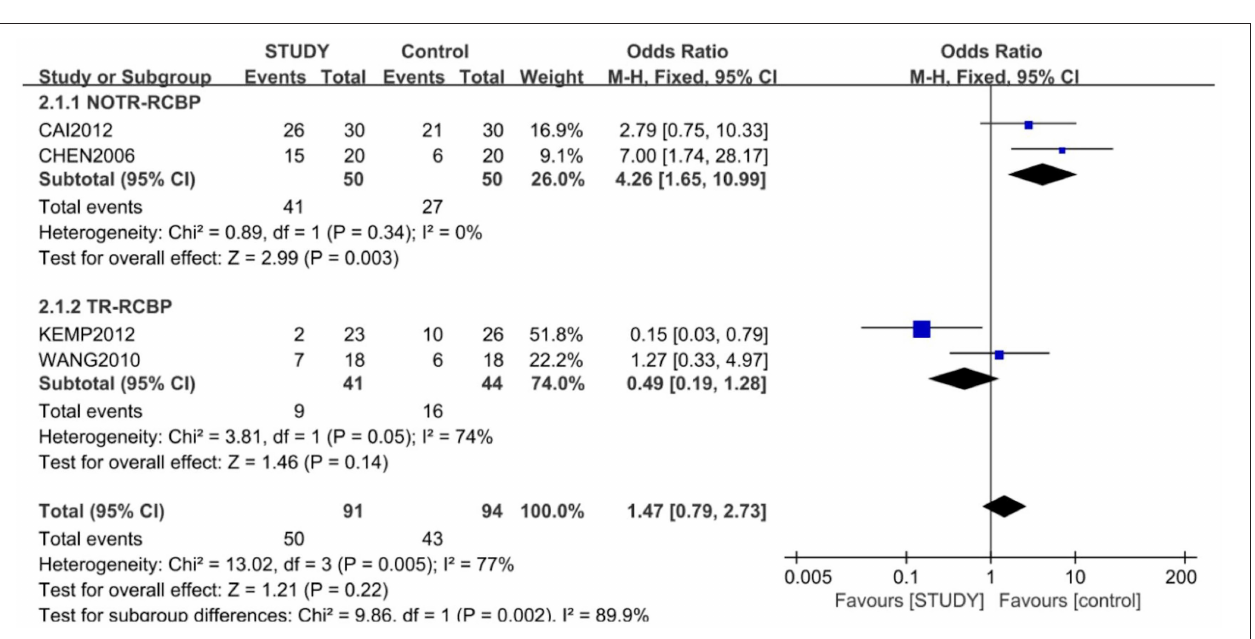
FIGURE 5 | Subgroup analysis of response between the study and control groups. A subgroup meta-analysis for response rate was also conducted according to treatment-resistant or not. The response rate of the lamotrigine and lithium combination was significant higher than that of the monotherapy of lithium in patients with no treatment resistance (82 vs. 54%;OR = 4.26; 95% CI: 1.65 ∼ 10.99; Z = 3.99; P < 0.01) with the fixed-effects model ( X 2 = 0.89, df = 1, P > 0.05, I 2 = 0%), but the response rate of lamotrigine, lithium, and valprorate combination was not significantly higher than that of placebo, lithium, and valprorate combination in patients with treatment resistance (21.9 vs. 36.3%; OR = 0.49; 95% CI: 0.0.19 ∼ 1.28; Z = 1.46; P > 0.05), with the random-effects model ( X 2 = 3.81, df = 1, P = 0.05, I 2 =